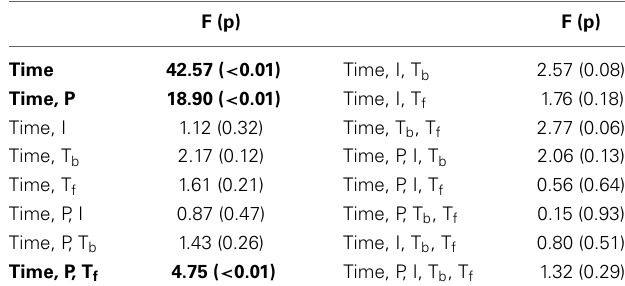
Table 2 | ANOVA results of interactions including the Time factor